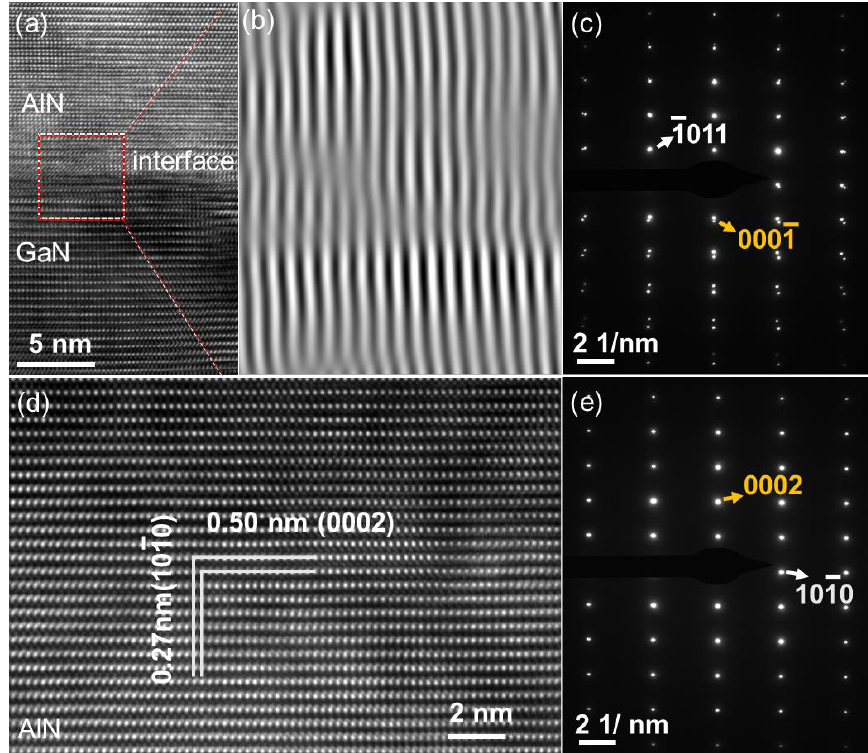
Figure 2. ( a ) Cross-sectional HRTEM image of the AlN/GaN interface. ( b ) Filtered images from masked fast Fourier transformation of the selected area in ( a ), showing misfit dislocations of (10 1̅ 0) planes. ( c ) SAED diagram at the interface. ( d ) HRTEM and ( e ) SAED diagram of the AlN photosensitive layer.